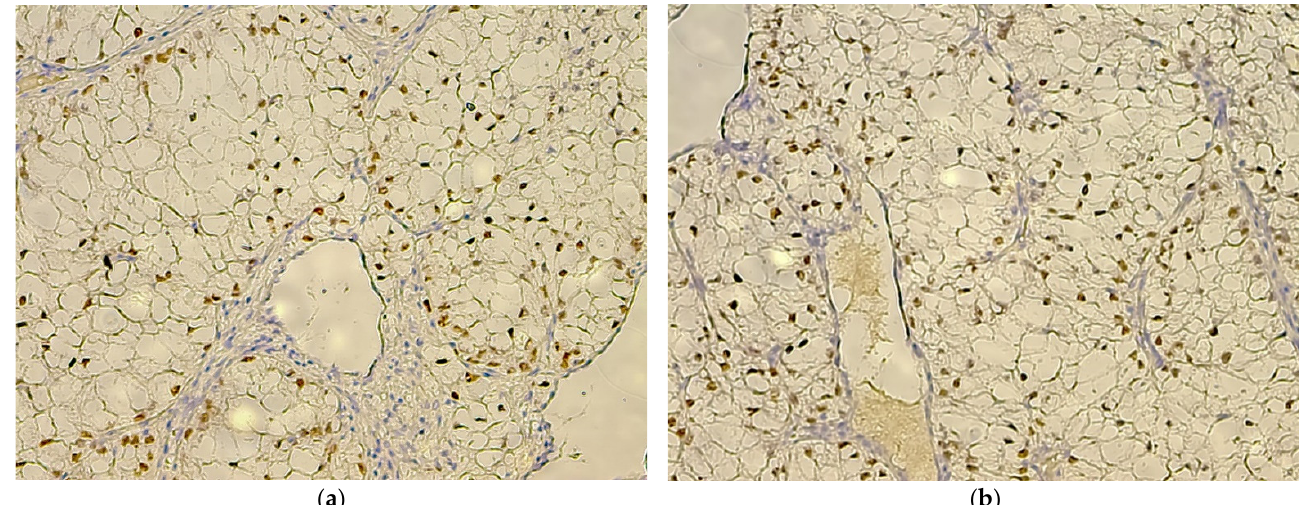
Figure 4. High-density clear cell nuclear WT1 IHC staining (+3), moderate intensity. ( a ) Case 1: 200×. ( b ) Case 2: 200×. Table 3. Positive intratumoral WT1 staining cases.